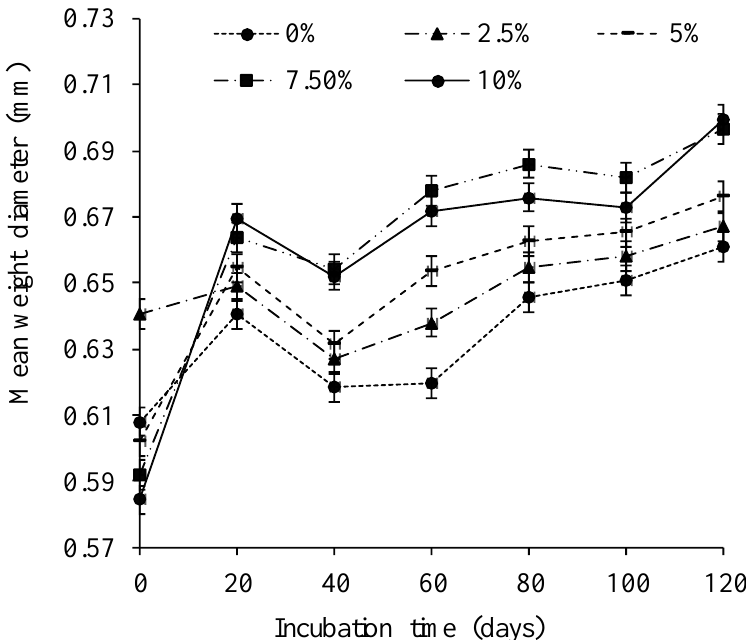
Figure 7 . Changes in mean weight diameter (MWD) during incubation of a Hutton soil amended with different biochar rates. Error bars indicate SD.